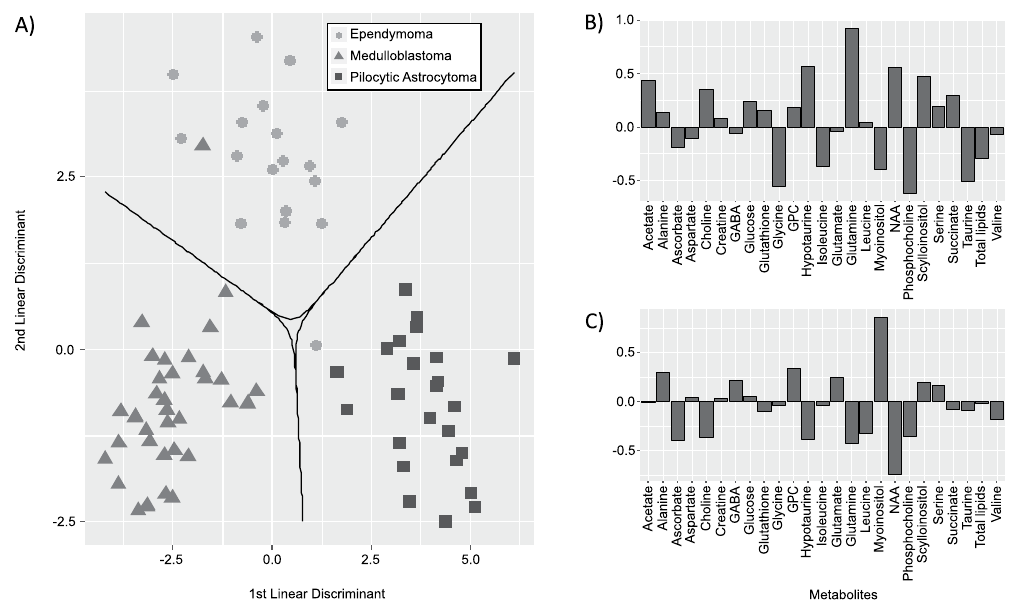
Figure 3. The output of the linear discriminant analysis. ( A ) The LDA scatterplot displays clear separation of the ependymoma (n = 18), medulloblastoma (n = 36) and pilocytic astrocytoma (n = 24). The decision boundaries, shown by the solid line, define the regions of the plot for each tumor type. ( B ) The loadings for the first discriminant function. The metabolites with more negative loadings are important for medulloblastoma classification, whilst metabolites with more positive loadings are important for pilocytic astrocytoma classification. ( C ) The loadings for the second discriminant function. Metabolites with more positive loadings are important for separating ependymoma from the other two tumor types. Abbreviations – GABA, gamma- aminobutyric acid; GPC, glycerophosphocholine; NAA, N-acetylaspartate; PCh, phosphocholine.